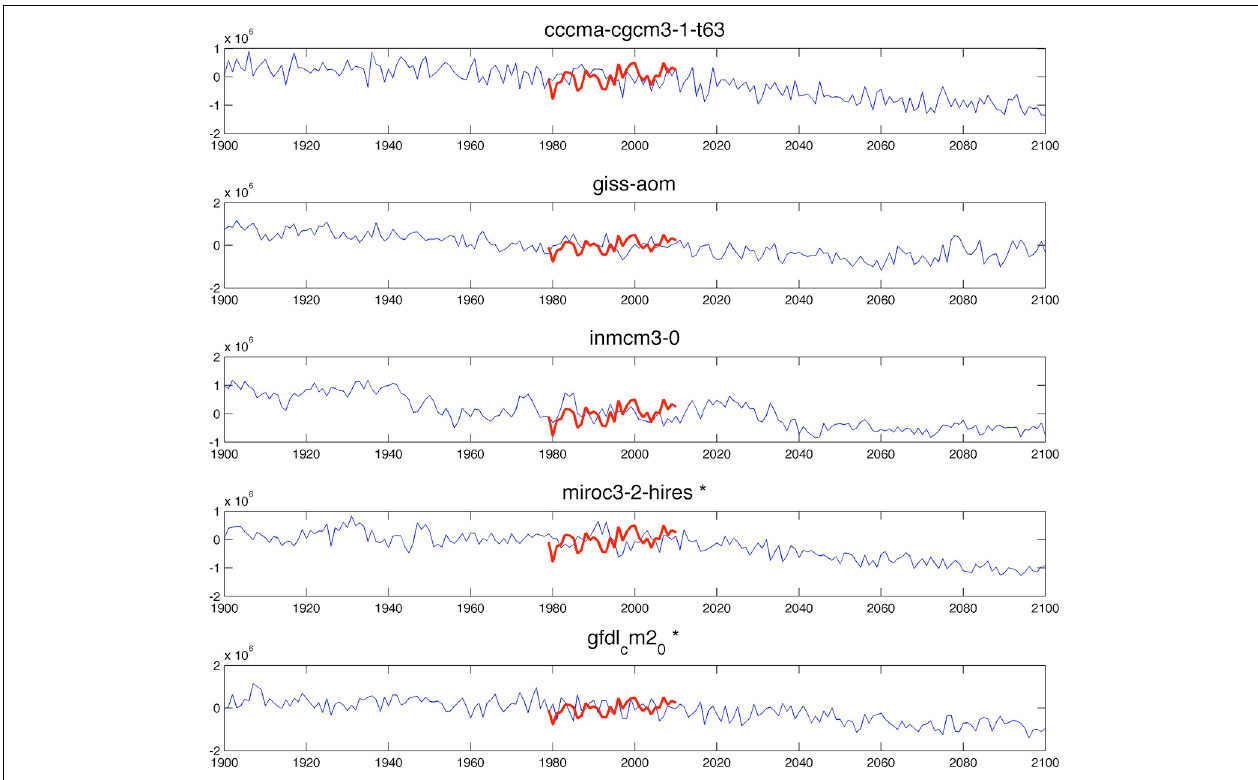
FIGURE 5 | Comparison of Ross Sea sea ice extent values derived from satellite observations (red line) and Ross Sea sea ice values derived from the AOGCMs that were retained (blue line). Models miroc3-2-hires and gfdl_cm2_0 were two of the four best models for the Ross Sea in Ainley et al.